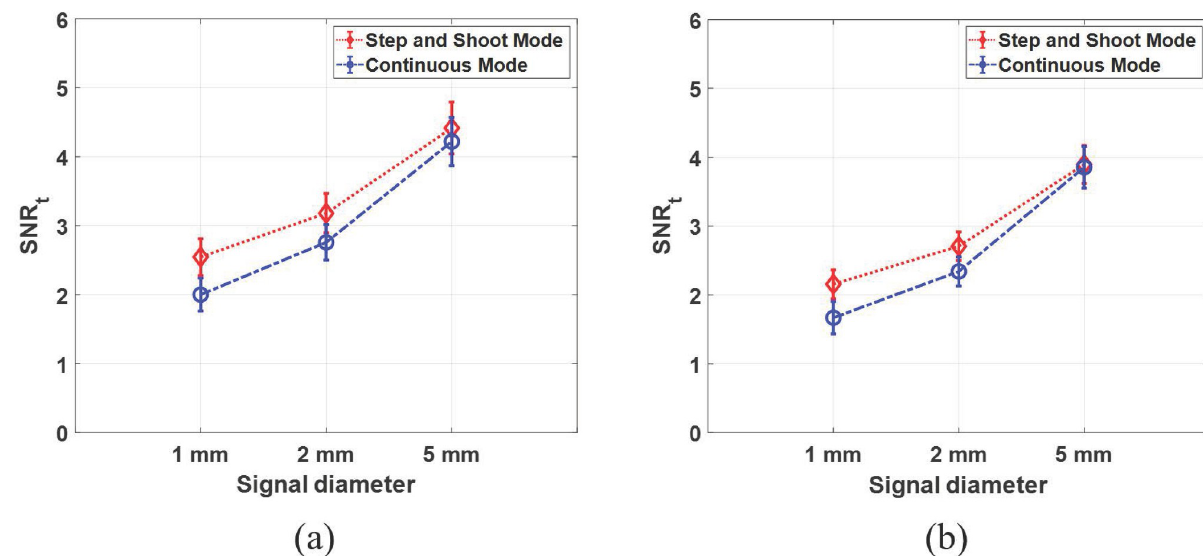
Fig 9. SNR t values of model observers for reconstructed images of (a) simulated breast phantom and (b) BR3D breast phantom. The SNR t values of model observers with 95% confidence intervals.